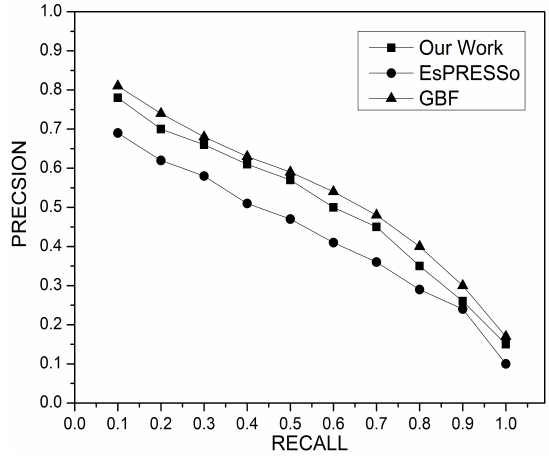
Figure 11. Performance of precision and